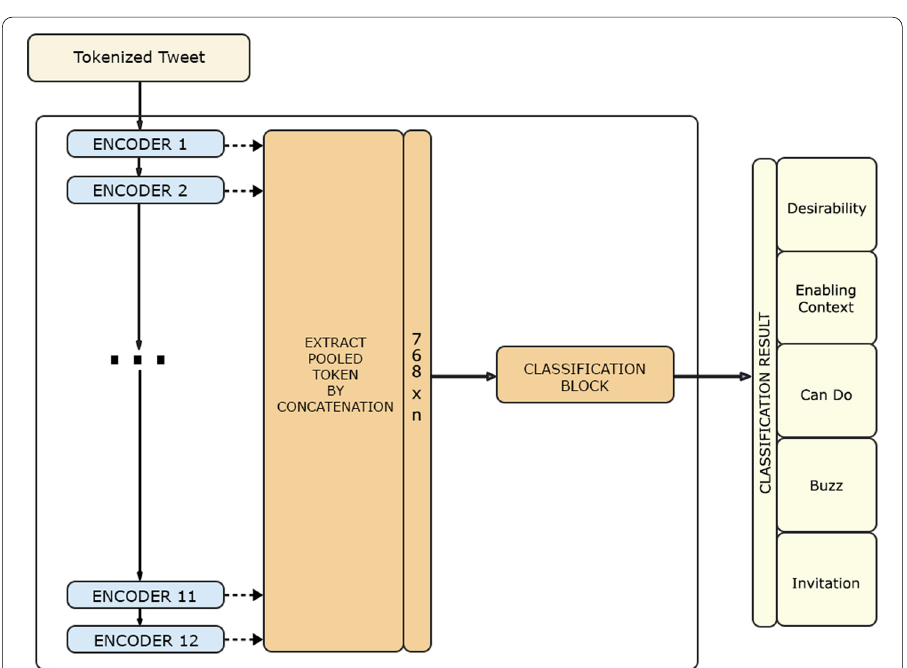
Fig. 6 BERTweet Embedding Extraction